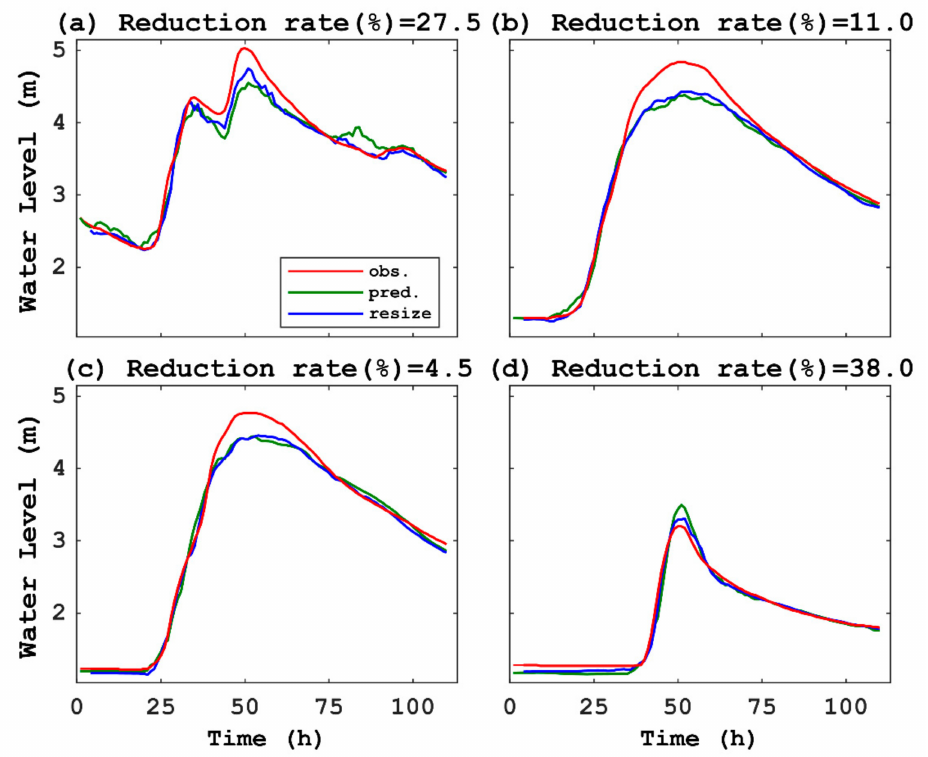
Figure A2. Comparisons among observed data (obs.), prediction with original image (pred.), and prediction with resized image (resize) in four test datasets for water level (m) versus time (hour) in Domain B, using CNN without transfer learning: ( a ) highest flood event, ( b ) second highest flood event, ( c ) third highest flood event, and ( d ) moderate peak flood